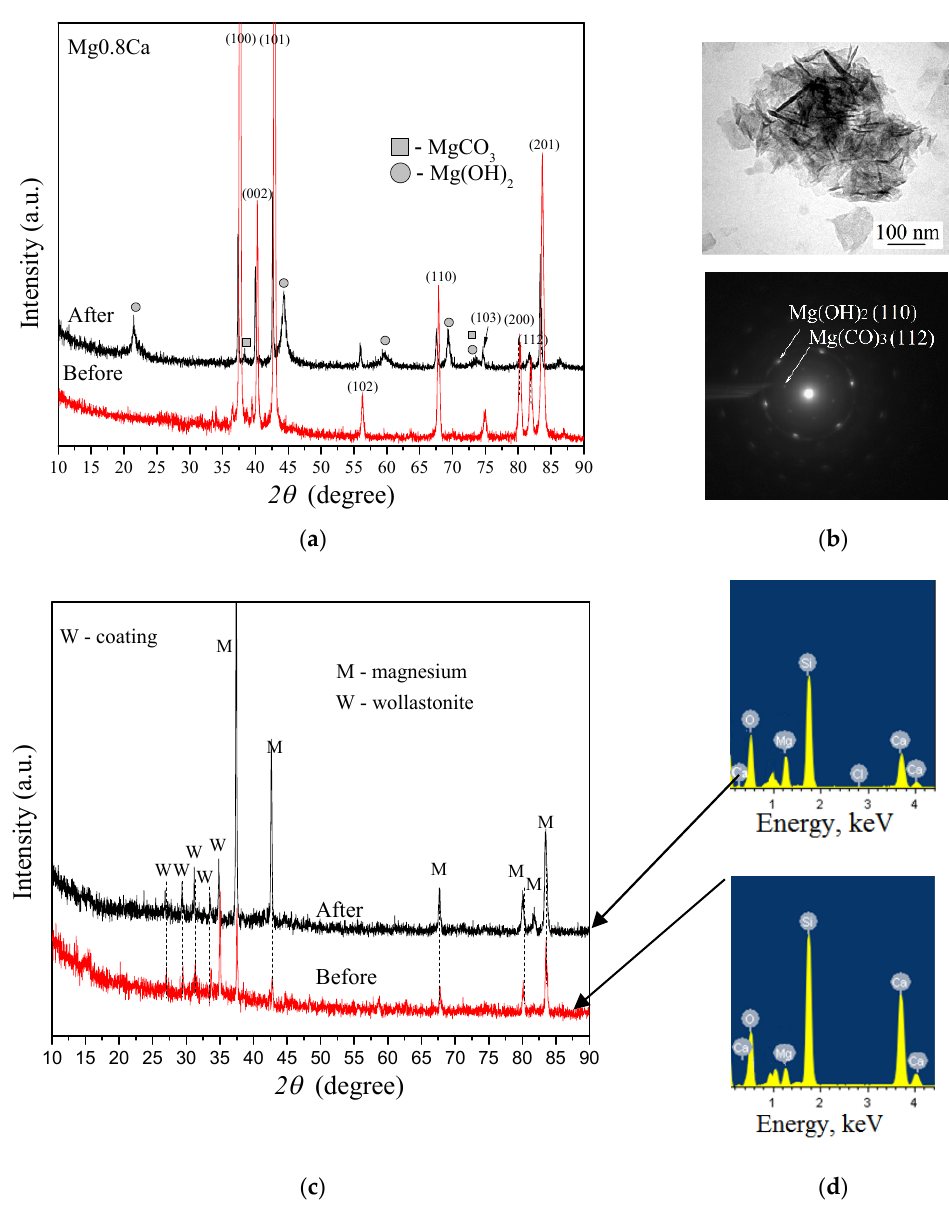
Figure 12. XRD patterns ( a , c ), SAD pattern and light-field TEM image ( b ), EDX energy spectra ( d ) of the Mg0.8Ca alloy ( a , b ) and of the W-coatings ( c , d ) before and after 16-day dissolution in 0.9% NaCl.